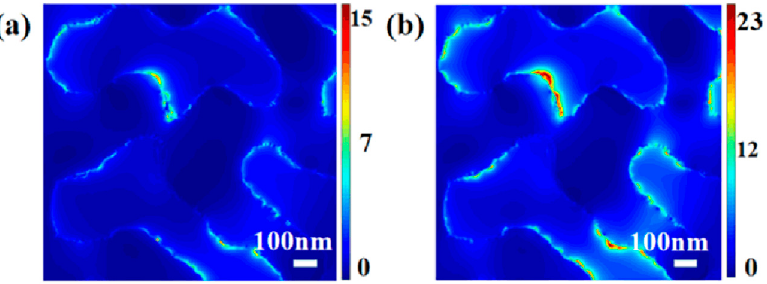
Figure 4. FDTD simulation for local surface electric field distribution of ( a ) bare NPG and ( b ) 1 nm carbon ‐ layer ‐ coated NPG.